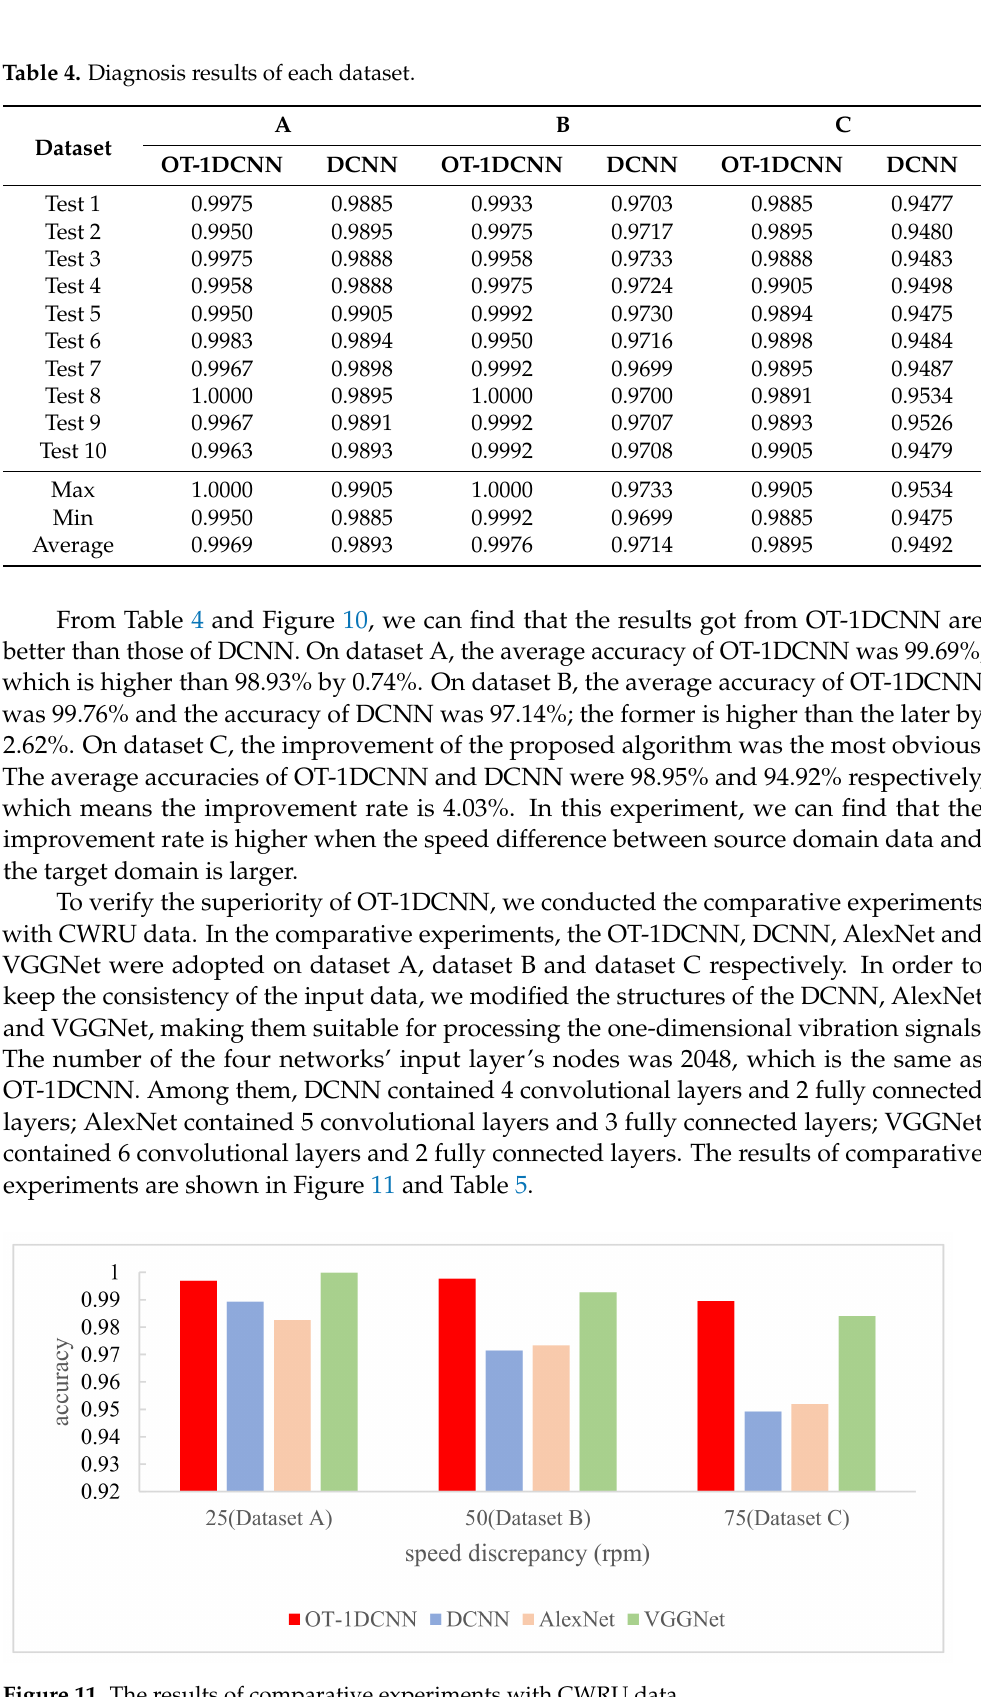
Figure 11. The results of comparative experiments with CWRU